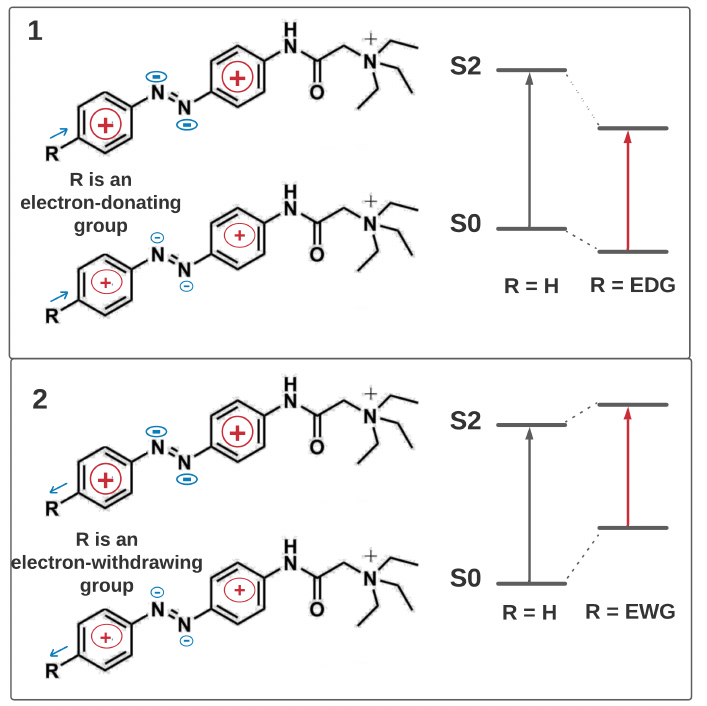
Figure 7. The effect of the charge transfer on the absorption maximum of the considered